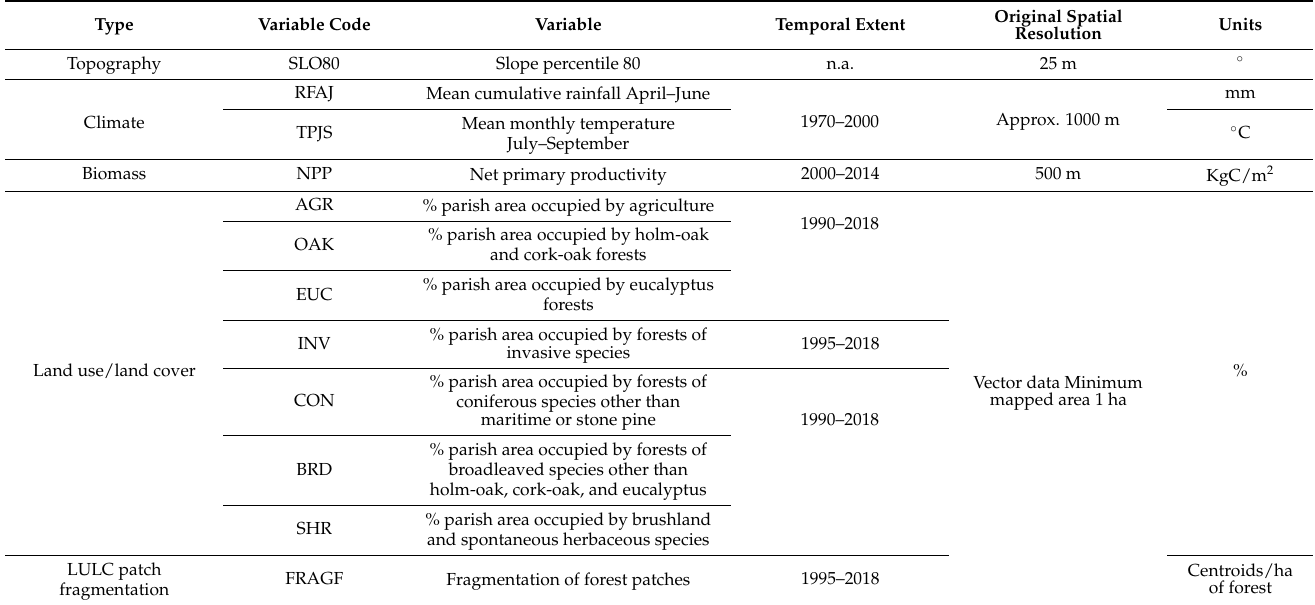
Table 1. Description and characteristics of the potential fire regime